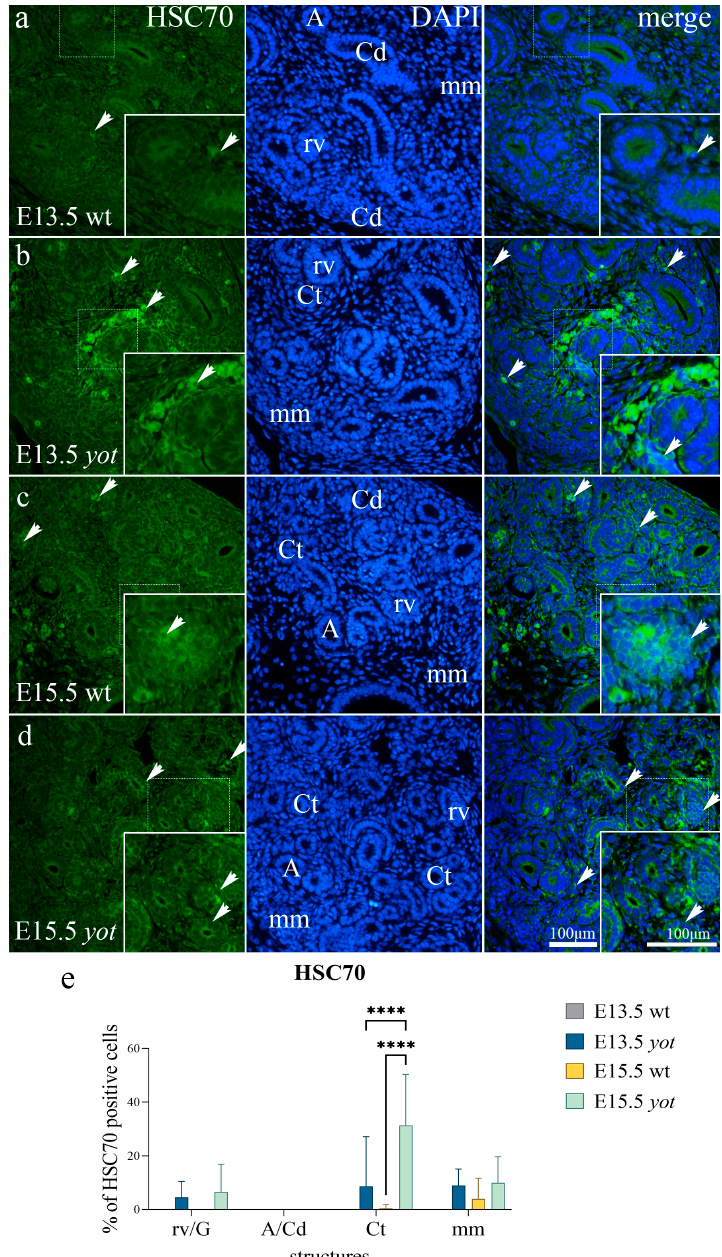
Figure 5. Immunofluorescence staining of developing wild-type (wt) ( a , c ) and yotari ( b , d ) mouse kidneys with HSC70 marker and DAPI nuclear staining. Three mice were used for each genotype (yotari and wt) at every observed time point. Arrows show the expression pattern of HSC70 in the metanephric mesenchyme (mm), renal vesicles (rv), glomeruli (G), convoluted tubules (Ct), ampullae (A), and collecting ducts (Cd) indicated on the 4 ′ ,6-diamidino-2-phenylindole (DAPI) image. The most prominent protein expression area is shown in the inserts, corresponding to the dashed boxes. Images were taken at a magnification of ×40. The scale bar is 100 µm, which refers to all images. Graph ( e ) shows the distribution of the percentage of HSC70-positive cells in the metanephric mesenchyme (mm), renal vesicles (rv) or glomeruli (G), convoluted tubules (Ct), and ampulla (A) or collecting ducts (Cd) of wild-type and yotari kidneys at embryonic days E13.5 and E15.5. Data are presented as the mean ± SD (vertical line) and analyzed by a two-way ANOVA test followed by Tukey’s multiple comparison test. Significant differences are indicated by **** p < 0.00001. At each time point, ten substructures were assessed.